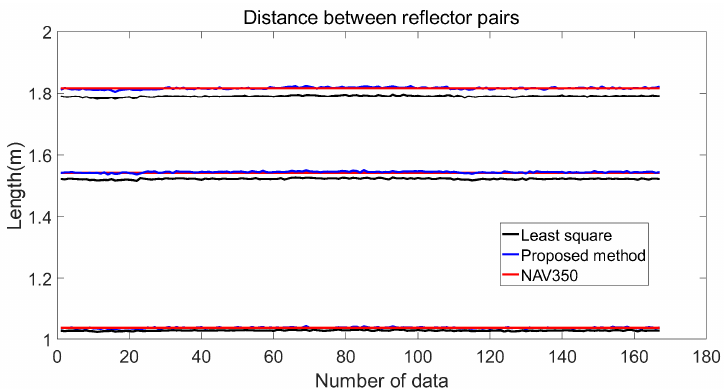
Figure 17. The distances between reflector pairs calculated by different methods. Black lines are the distances calculated by the traditional least square. Blue lines are the distances calculated by the proposed method. Red lines are the distances calculated by NAV350, which uses a traditional reflector positioning system. Blue lines almost coincide with red lines and the black lines do not.